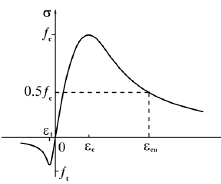
Figure 6. Stress-strain relationship for concrete.